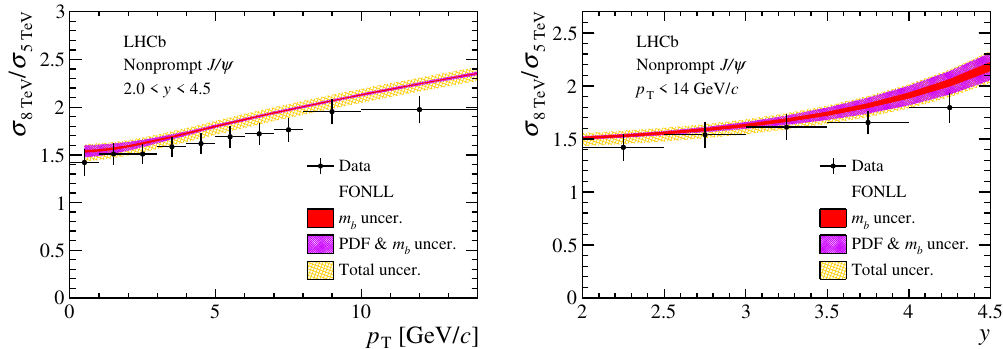
Figure 8 . Ratios of differential cross-sections between 8 TeV and 5 TeV measurements as a function of (left) p T and (right) y for nonprompt J/ψ mesons compared with FONLL calculations [58, 59]. The orange band shows the total FONLL calculation uncertainty; the violet band shows the uncertainties on PDFs and that due to b -quark mass added in quadrature; the red band shows only the uncertainty due to the b -quark mass.